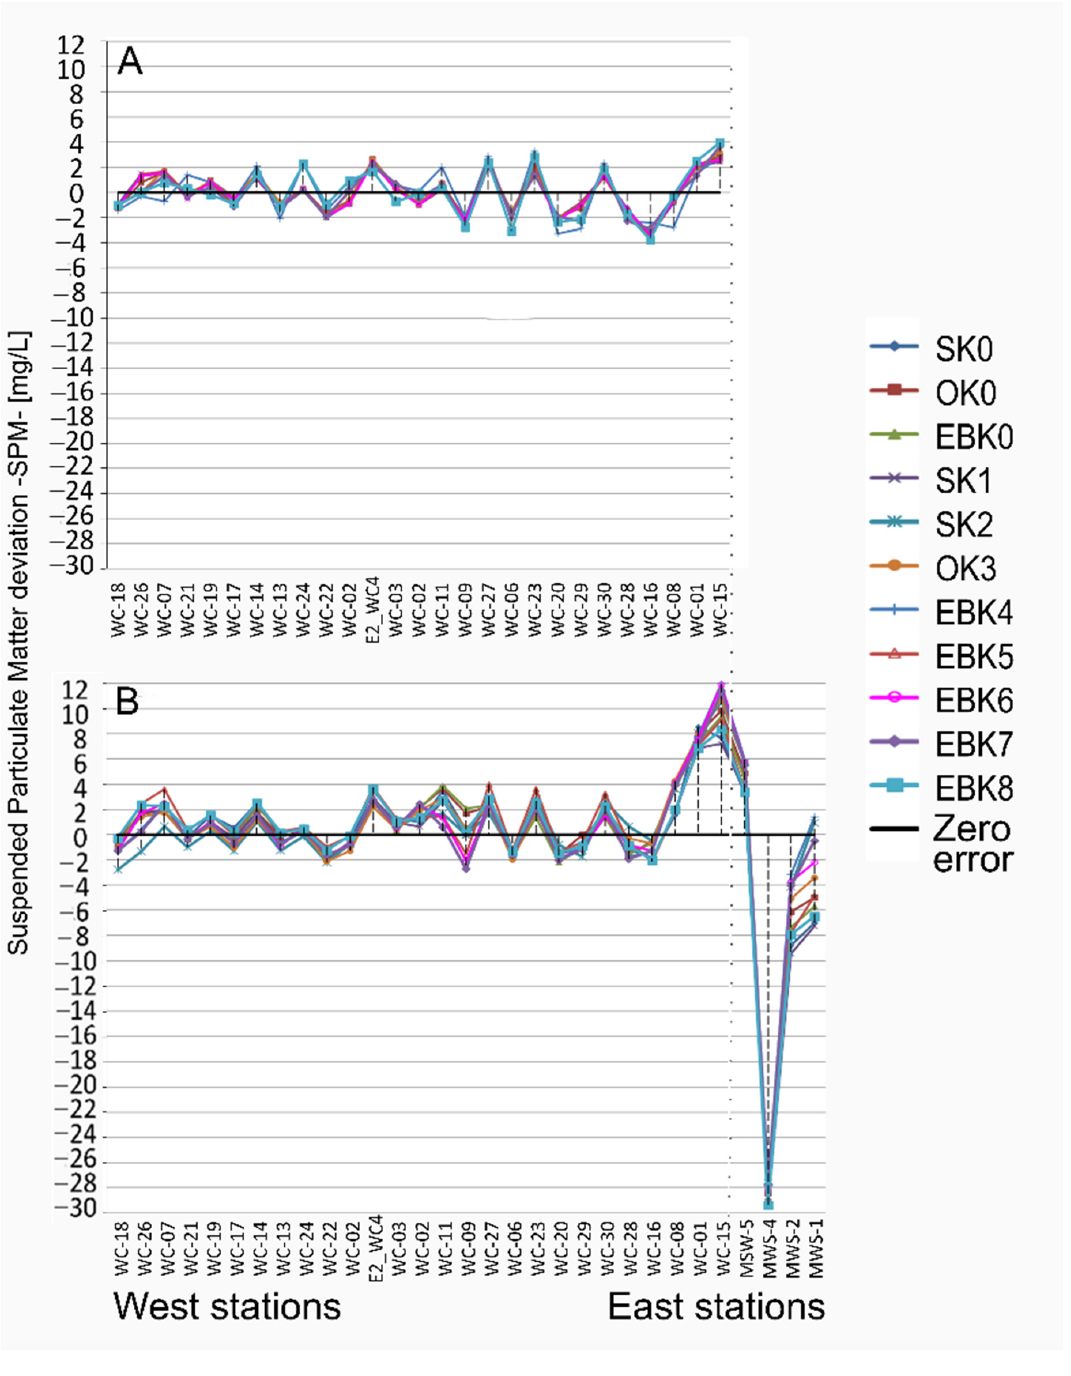
Figure 9. Statistical deviation error (DEs) per station resulting from each geostatistical model. Suspended particulate matter (SPM) predictions reveal a misclassification gradient from the west to the east in Potter Cove, coincident with a gradient of distance to the meltwater stream (MWS) discharge areas. ( A ) Deviation error for data sets without MWS represents ± 4 mg / L from the SPM concentration measured. ( B ) Deviation error for data sets with MWS represent − 30 mg / L and + 12 mg / L from SPM concentration